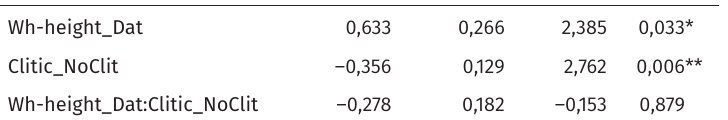
Table 6: Study 2 – Generalized linear mixed model fitted by using lmer function in the lme4 package (with Gaussian